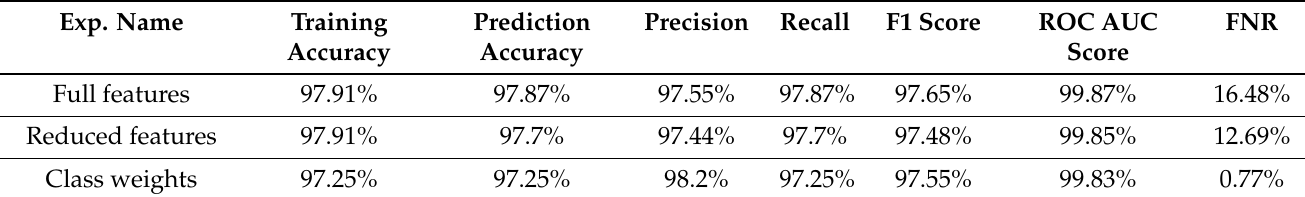
Table 24. Comparison of the results achieved in the UNSW-NB15 multiclass classification experiments.